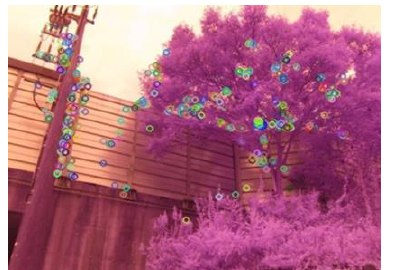
Figure 10. DN values on green band